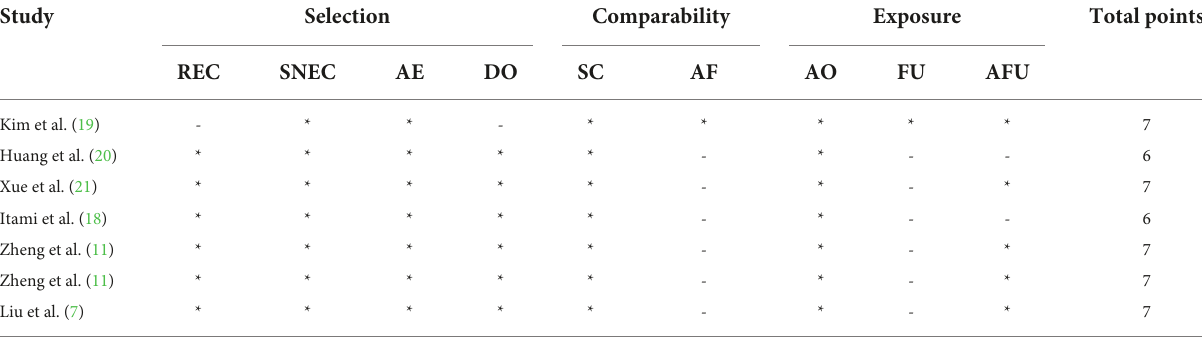
TABLE 2 Quality evaluation of the eligible studies with Newcastle–Ottawa scale.